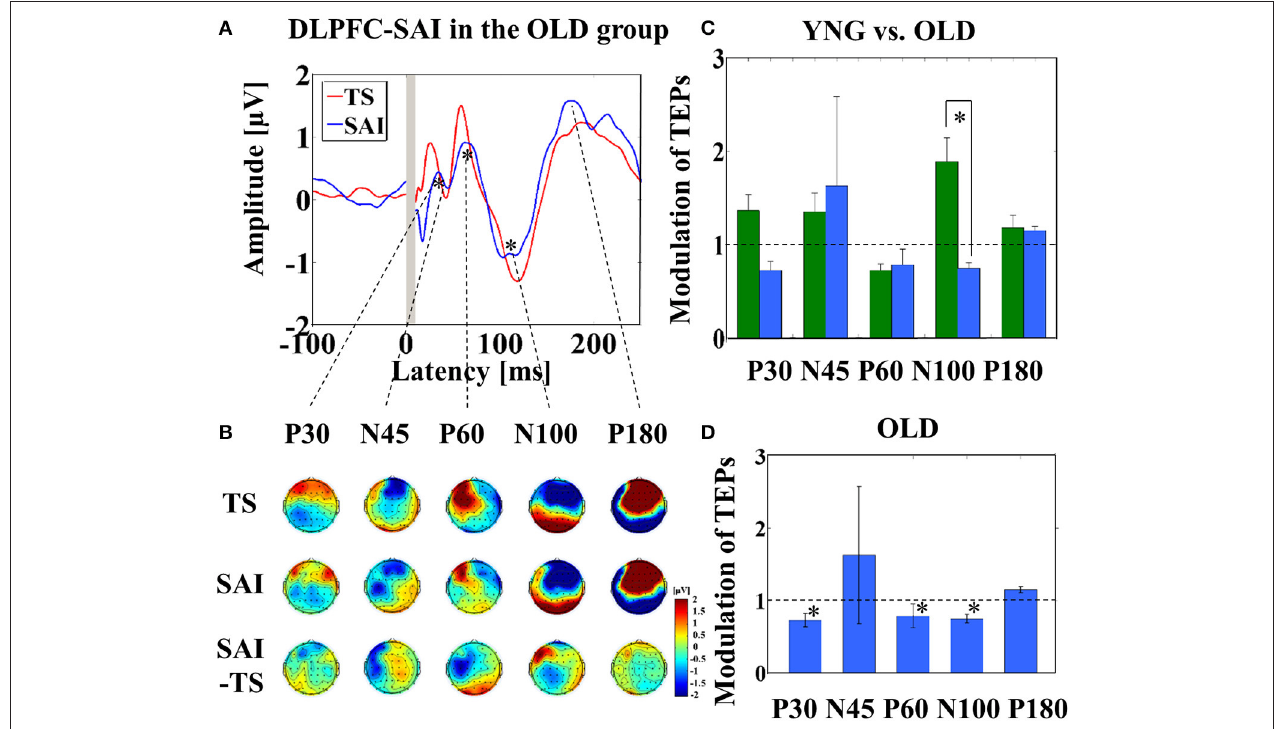
FIGURE 2 | Result of TEPs in the DLPFC–SAI paradigm. (A) The graph shows the TEP traces with individual SSEPs subtraction. The graph depicts TEP traces averaged across all participants for TS and SAI (ISI N20 + 4 ms) at the left frontal ROI. (B) The illustration shows the EEG topographical plots for TS, SAI (ISI of N20 + 4), and the difference between TS and SAI obtained from the DLPFC–SAI experiment. Each vertical column depicts the TEP topoplots for P30, N45, P60, N100, and P180 component from left to right, respectively. (C) The bar graph shows the group differences between younger (green bars) and older (blue bars) participants in the modulation of TEPs induced by DLPFC–SAI. The cutoff of the graph is ratio of 1. Older participants demonstrates significantly lower modulation in N100 TEP (t 22 = 2.921, p = 0.008) in this paradigm. (D) The bar graph shows the modulation of TEPs within the older participants. The cutoff of the graph is ratio of 1. Older participants indicates significant modulation in P30 (t 11 = 3.204, p = 0.008), P60 (t 11 = 3.165, p = 0.009), and N100 (t 11 = − 4.871, p < 0.0001) TEPs by DLPFC–SAI. Significant findings are shown with